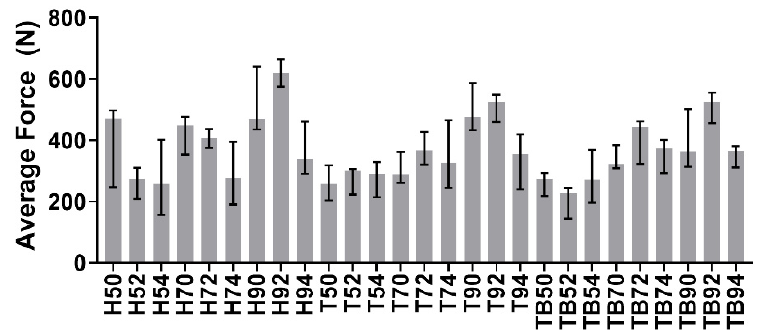
Figure 5. Medians and variability interval of average force value during the removals.